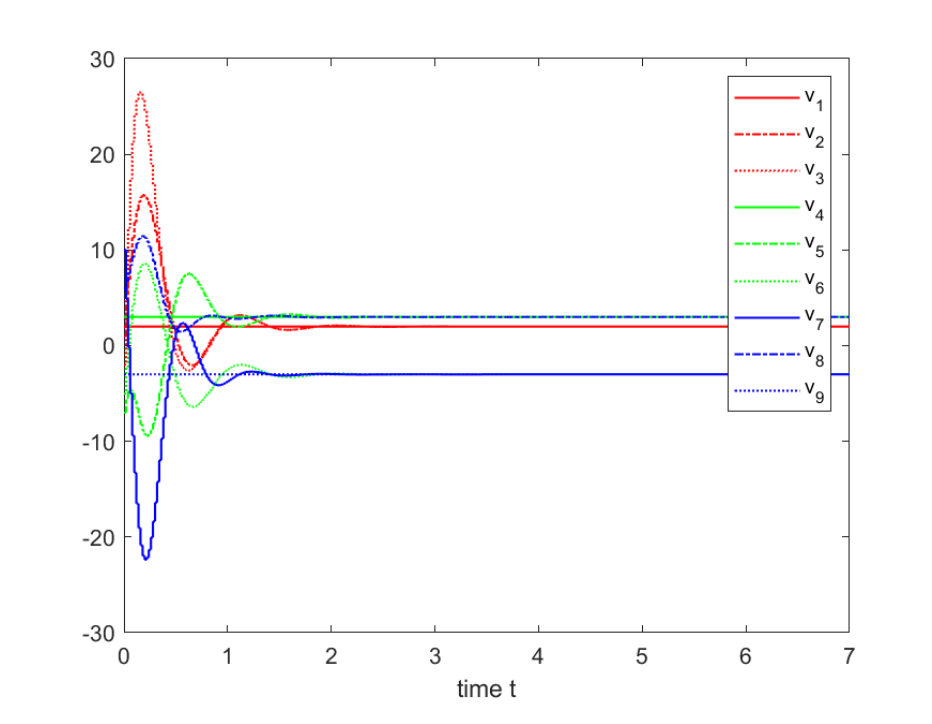
Figure 8. The time evolution trajectories of v i ( t ) , i = 1,2, · · · ,9, in Figure 6 of Example 2.